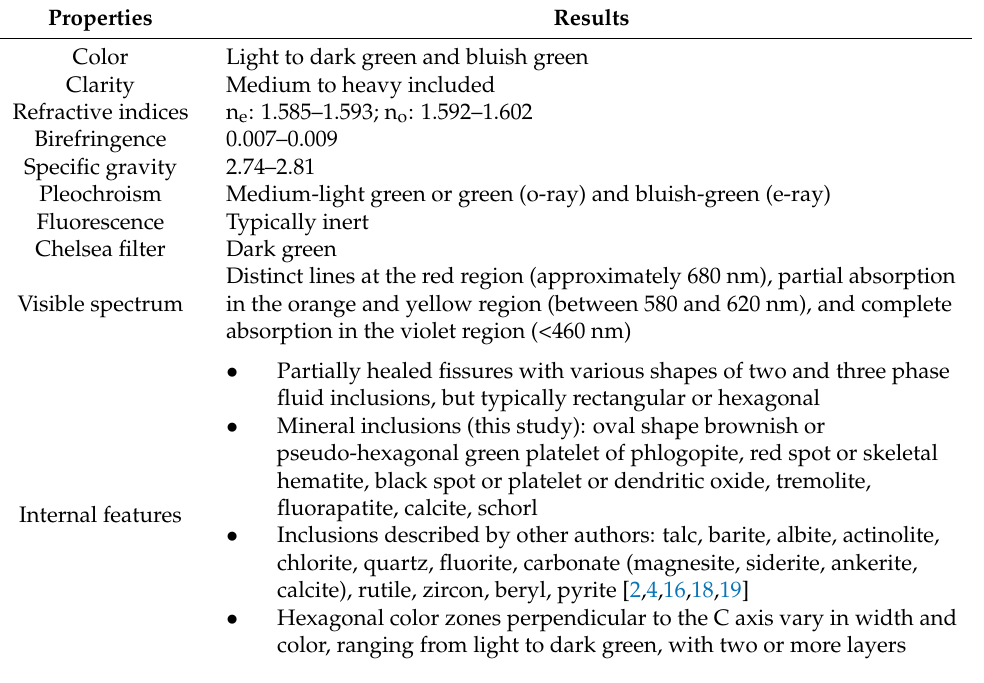
Table 1. Gemological properties of emeralds from Kamakanga,